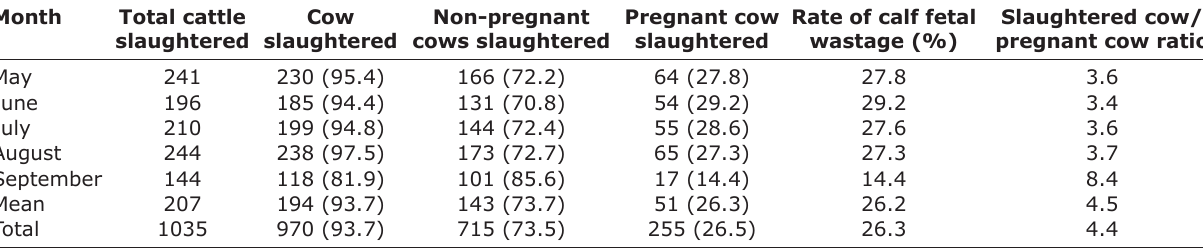
Table-1: Incidence of fetal wastage at ELAKAT provincial slaughterhouse. Month